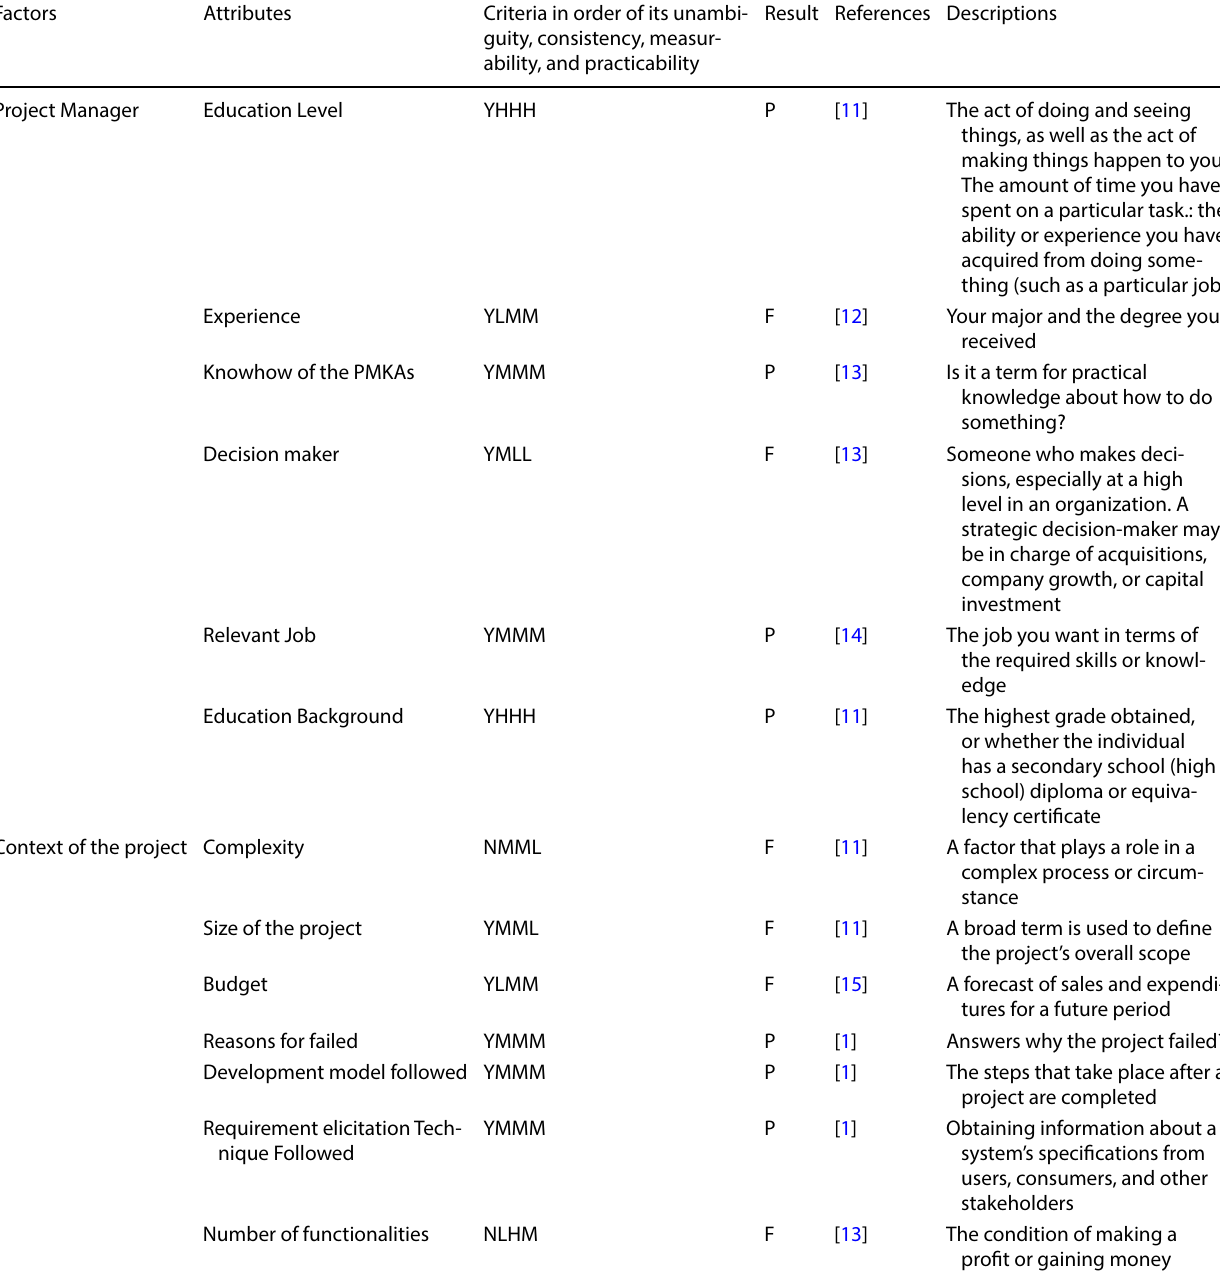
Table 2 Identified attributes with their description and selected attribute using four criteria